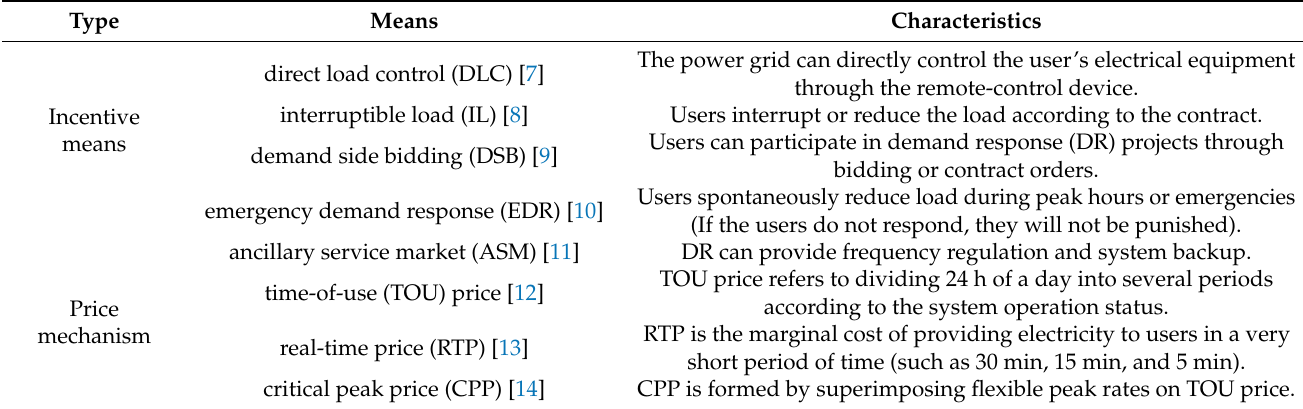
Table 1. The current incentive means and pricing